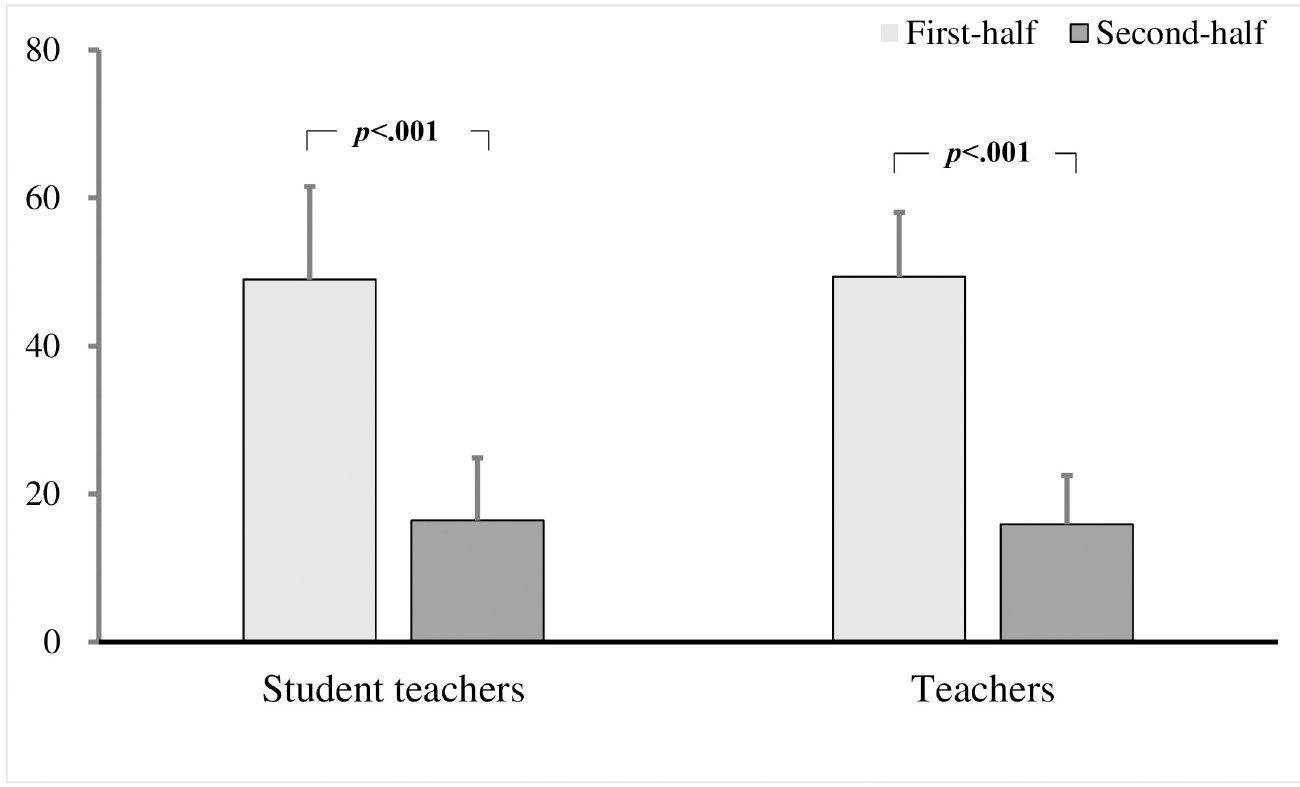
Fig 4. Number of fixations on non-target areas in student teachers and teachers. Bars show the mean across all comparisons (with standard deviation bars).